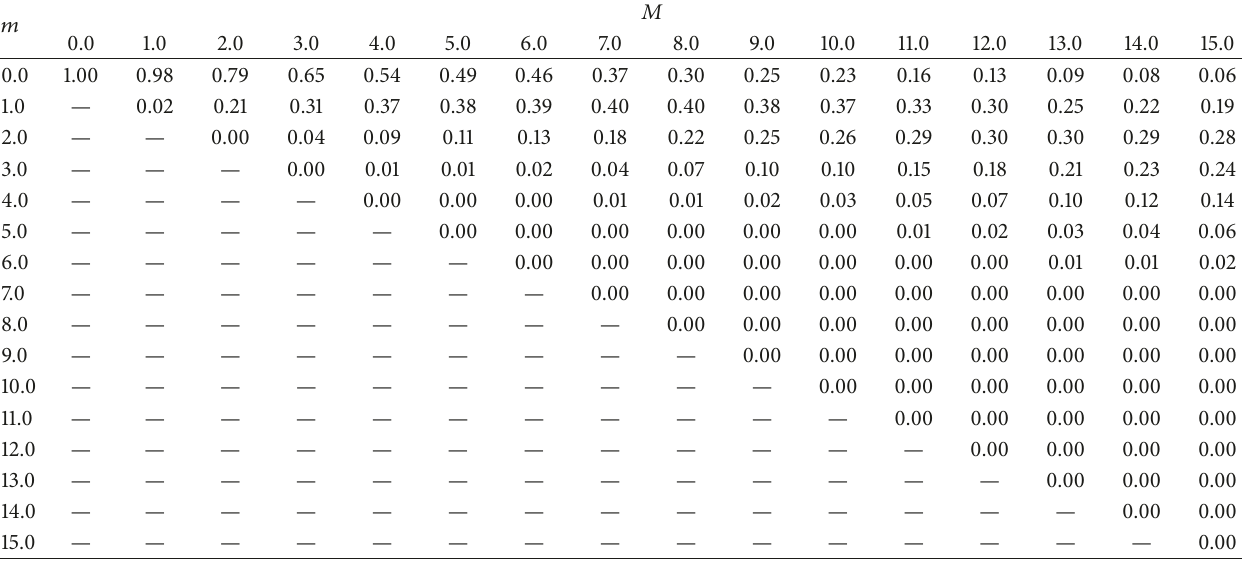
Table 3: Traffic demand and probability distribution in interval 07: 00-07: 14 of sector AR01.